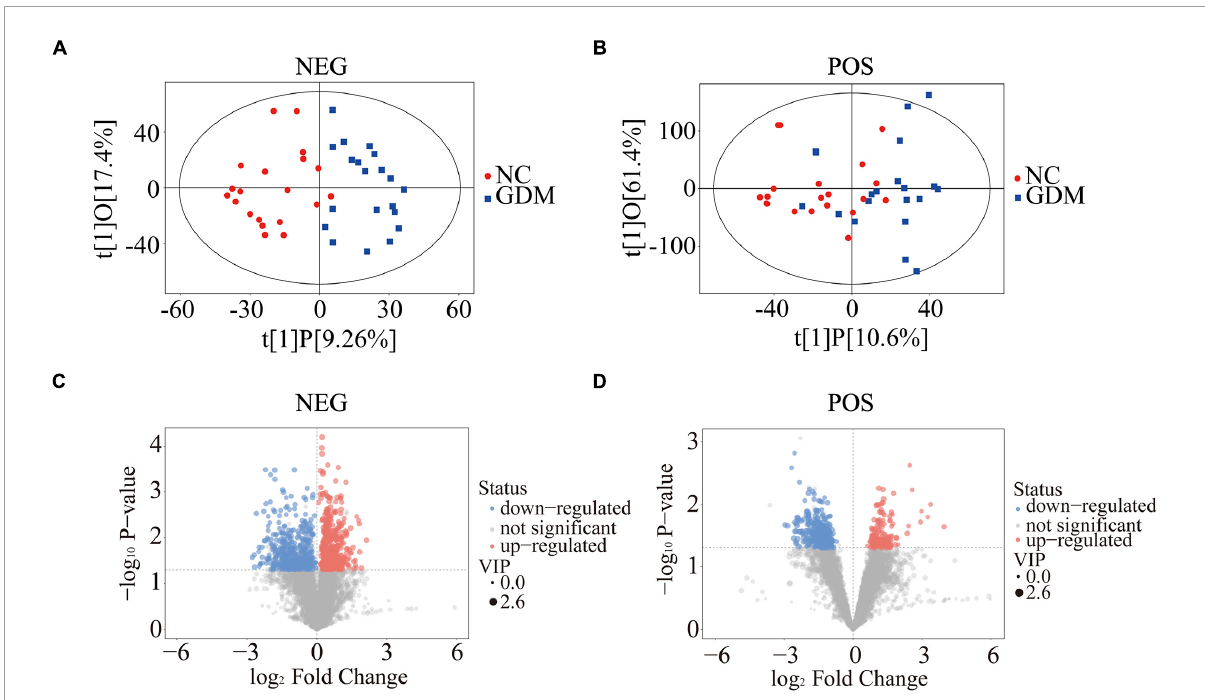
FIGURE1 Lipid profiling changes in breast milk response to GDM. Score scatter plots of OPLS-DA for negative ion mode (A) and positive ion mode (B) . Volcano plots showed the difference of molecular features in negative ion mode (C) and positive ion mode (D) . OPLS-DA, orthogonal projections to latent structures-discriminate